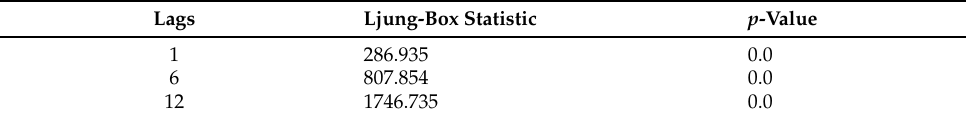
Figure 10. The SICs in sub-region No. 2 and the decomposed trend and seasonal components. Table 3. Ljung-Box white noise test of SICs in sub-region No. 2.